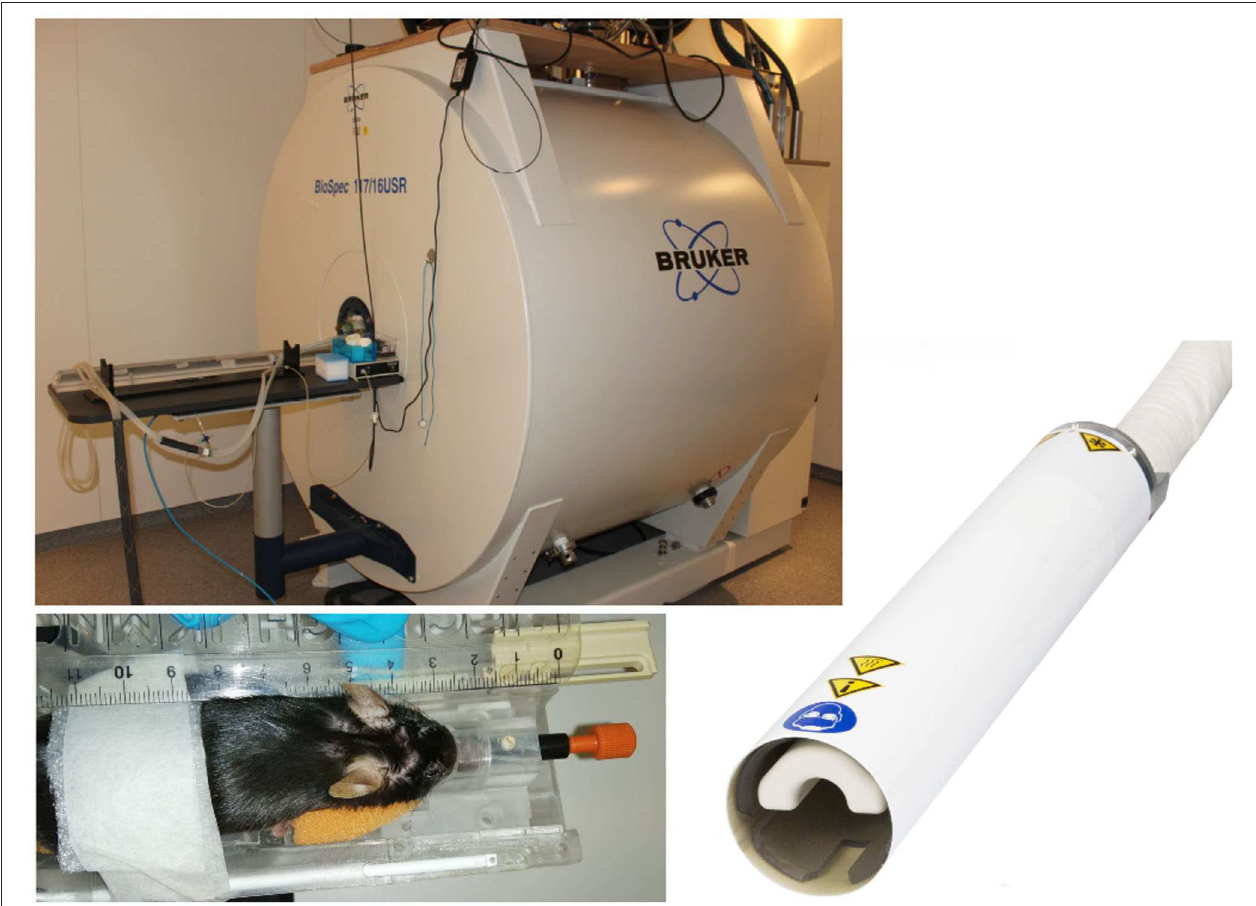
FIGURE 2 | Typical equipment for scanning of mouse cohorts. 11.7T tomograph (Biospec 117/16, Bruker, Ettlingen, Germany), two-element transmit/receive 1 H mouse cryogenic surface coil (Cryo-Probe, Bruker BioSpin); the animals are placed in a stereotaxic head support (Bruker Biospin, Ettlingen, Germany) to immobilize the head. Data acquisition is performed under isoflurane